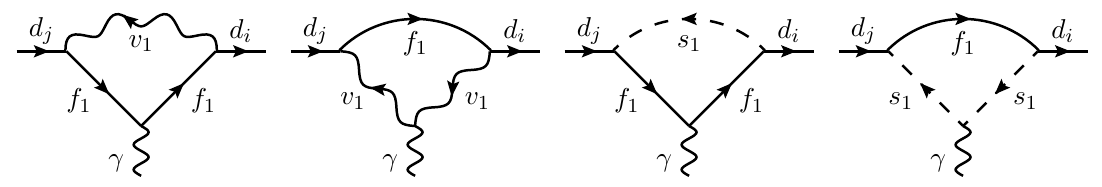
Figure 1 . Diagrams for the off-shell d j → d i γ Green’s function. Physical scalars are denoted by dashed lines, while the contribution of massive vector bosons and their related Goldstone bosons are denoted by a wavy line.